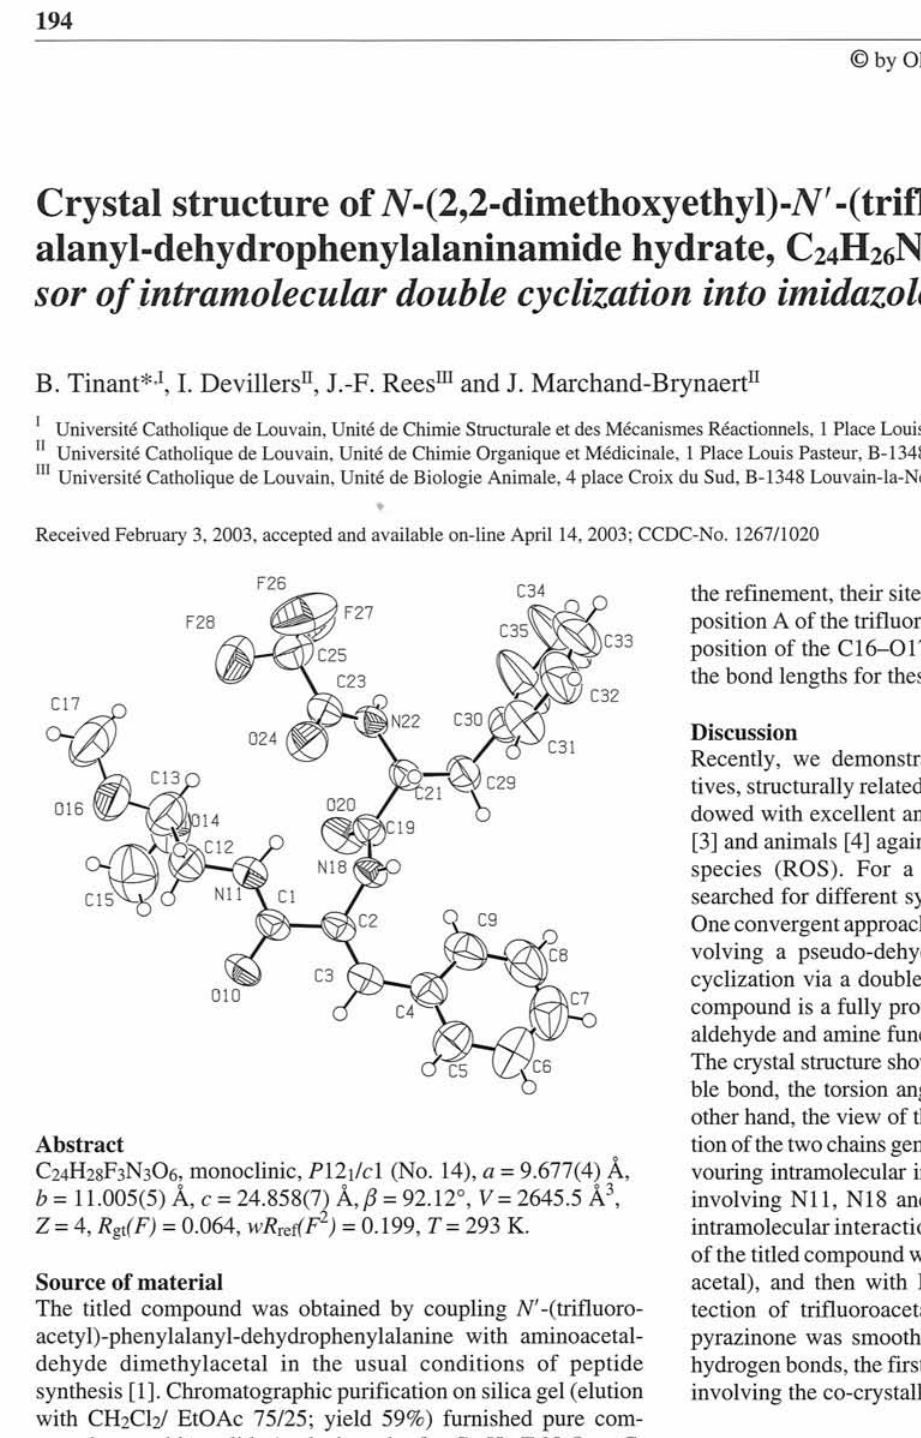
Table 1. Data collection and